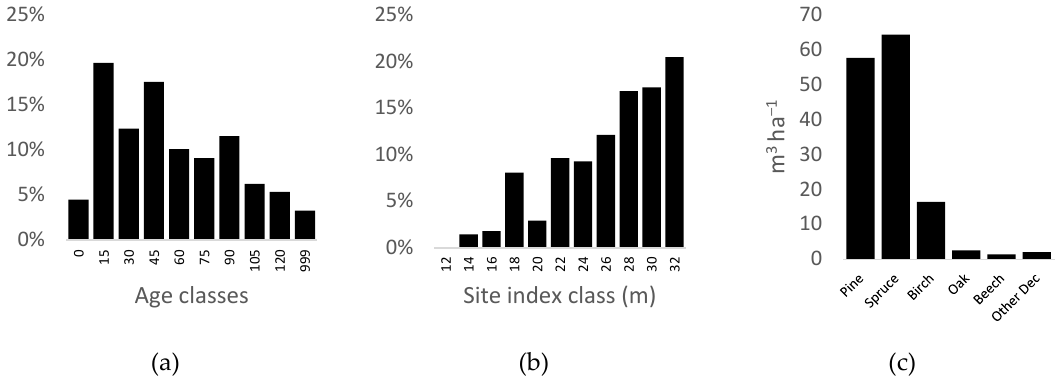
Figure 2. The initial state for forest variables for the 10 areas representing Kronoberg County with respect to ( a ) age class distribution, ( b ) site index H100 in 2 m classes, and ( c ) species distribution.